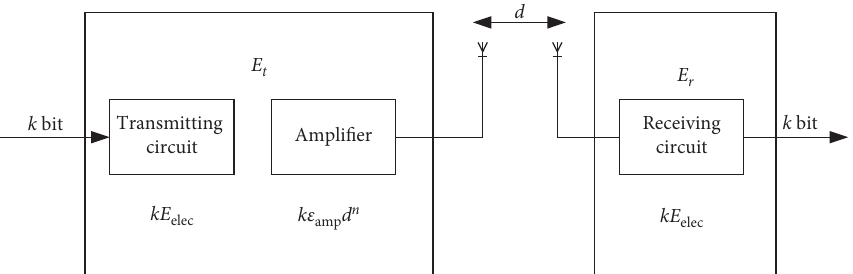
Figure 1: Node communication model